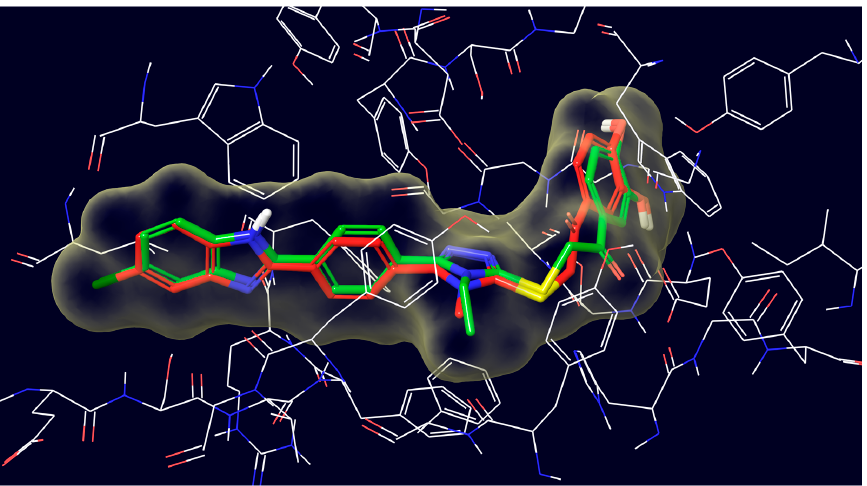
Figure 3. The superimposition pose of compounds 3d and 3h (red and green colored, respectively) in the enzyme active site (AChE PDB Code: 4EY7). Molecules 2019 , 24 , x FOR PEER REVIEW